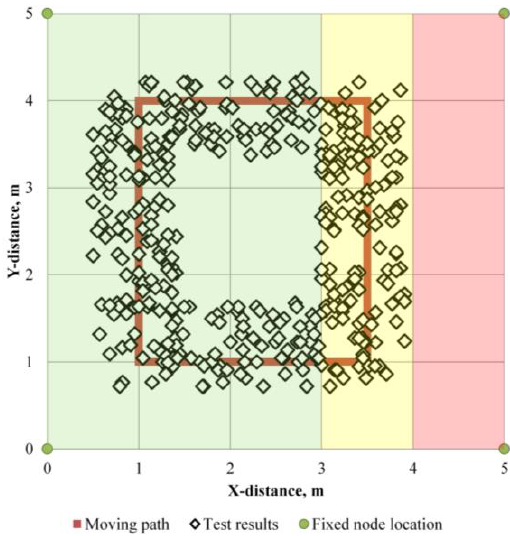
Figure 12. Tracking result of moving tag in a bridge overlay site.